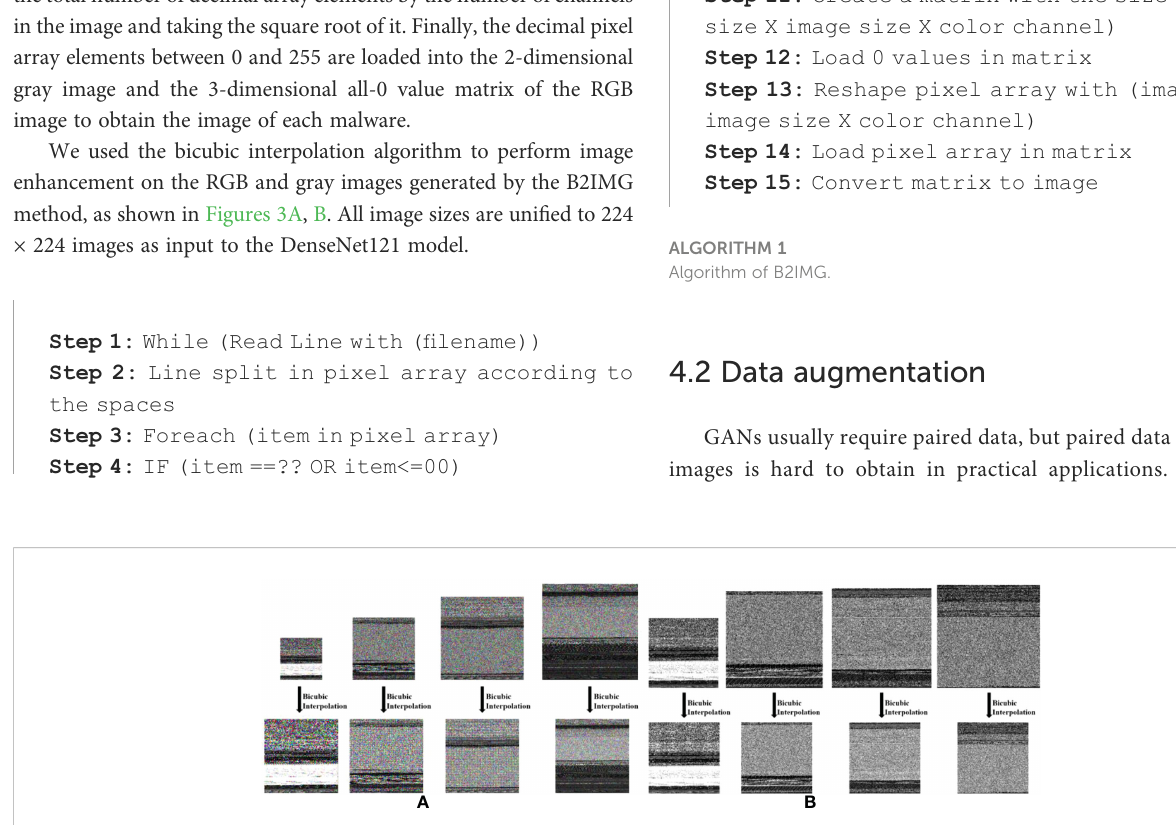
FIGURE 3 Images generated using the bicubic interpolation technique: (A) RGB image, (B) Gray